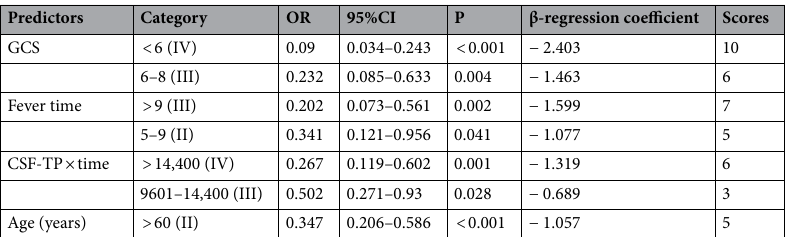
Table 3. Multivariate logistic analysis of the derivation cohort and the scoring system for the prediction of PHH. Assignment of points to risk factors was based on a linear transformation of the corresponding β-regression coefficient: the coefficient of each variable was divided by 0.689 (the lowest β-value, corresponding to CSF-TP x time (9601–14,400), multiplied by a constant (3), and rounded to the nearest integer. PHH post-hemorrhagic hydrocephalus, GCS Glasgow coma score, CSF-TP × time Cerebrospinal fluid total protein × time, OR odds ratio, CI confidence interval.